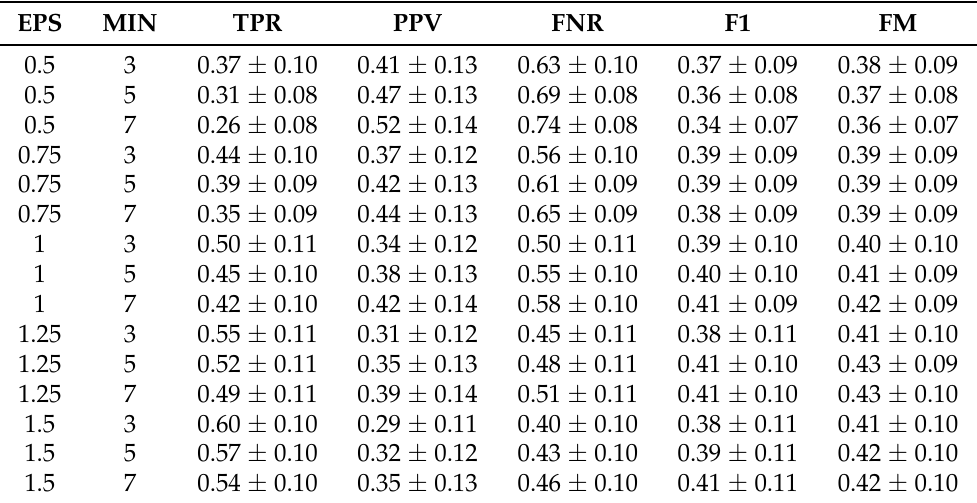
Table 6. Evaluation results of SLAM-OR (RetinaNet) algorithm depending of DBSCAN parame- ters